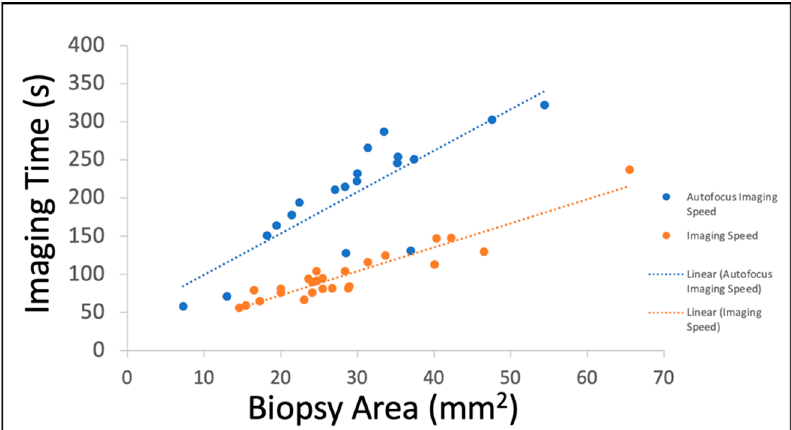
Figure 3. Imaging Time vs. Biopsy Area.